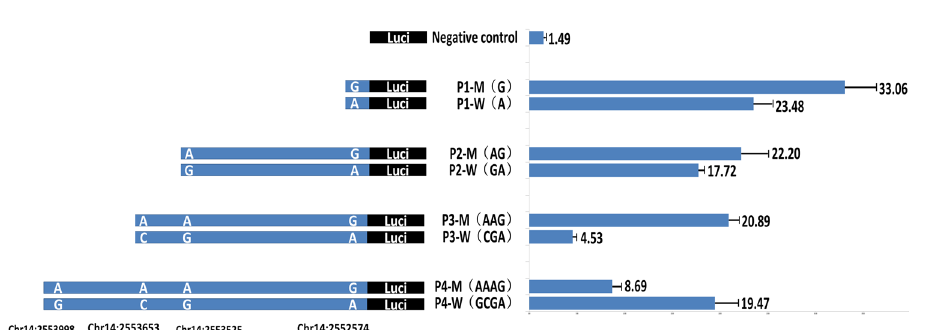
Figure 4. Promoter activity analysis of the bovine GPIHBP1 gene. There are four completely linked SNPs in the promoter region of GPIHBP1 . As shown, fragments P1, P2, P3, and P4 contain one, two, three, and four SNPs sites, respectively. We constructed eight types of recombinant promoter vectors with respect to the four fragments and the mutant and wild-type haplotypes. Promoter activities were detected using a dual-luciferase reporter system. The data are expressed as the means and standard errors of three